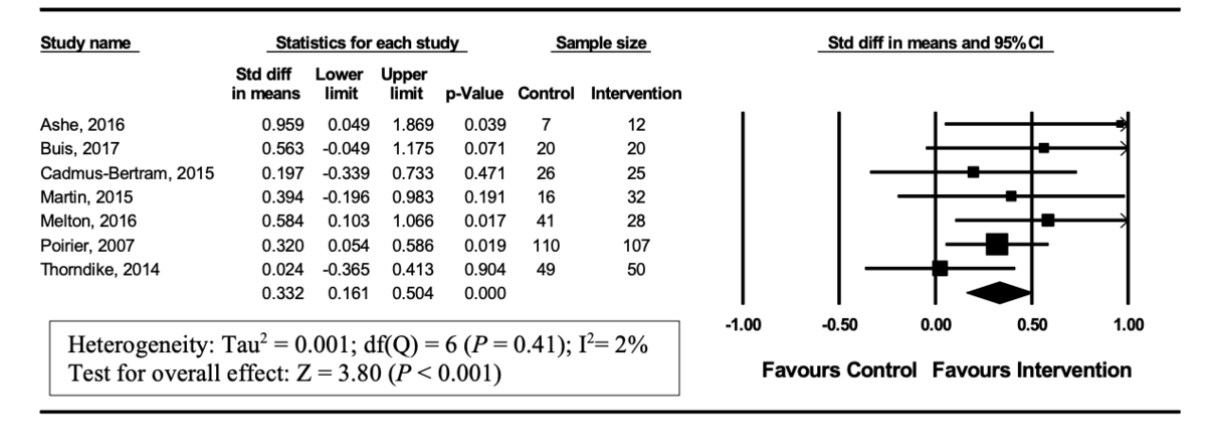
Figure 3. Forest plot of standardized mean difference (95% Cl) in the effect of wearable trackers on